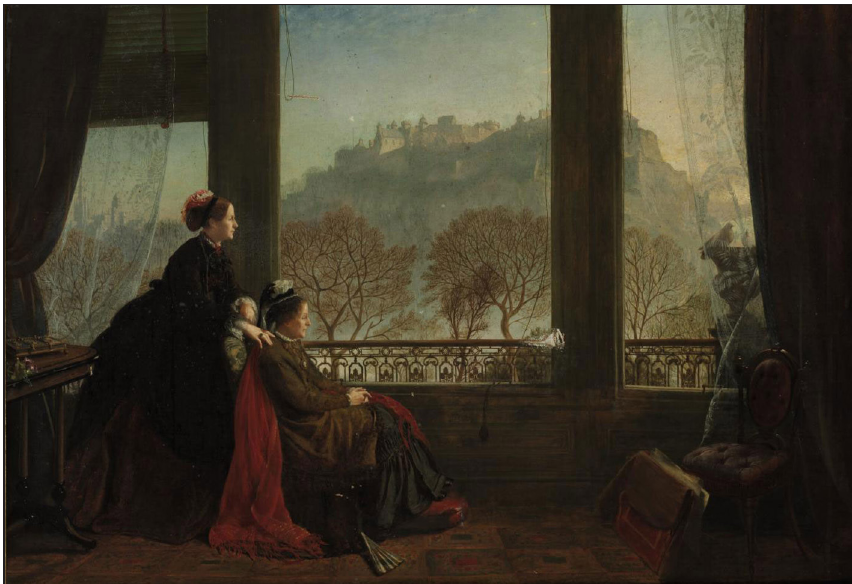
Fig. 7 : James Drummond, Portrait of the Baroness Burdett Coutts and Her Companion, Mrs Brown , Edinburgh , 1874, oil on canvas, 52.1 × 73.7 cm, private collection. ©